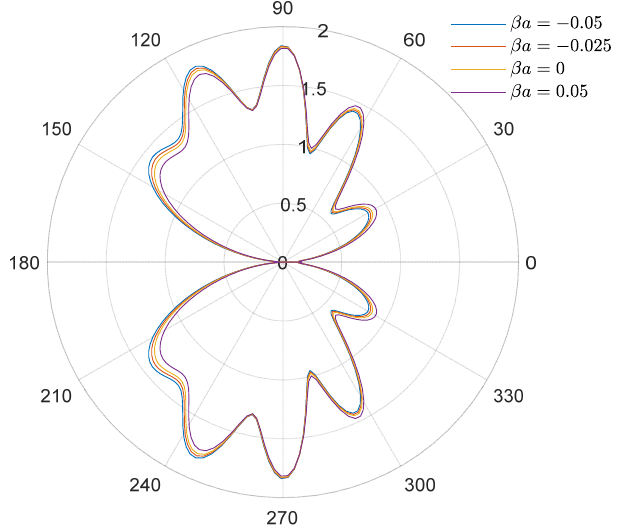
Figure 6. Polar graph of DSCF around the elliptical opening with ka = 2.0 and m = 1/6.